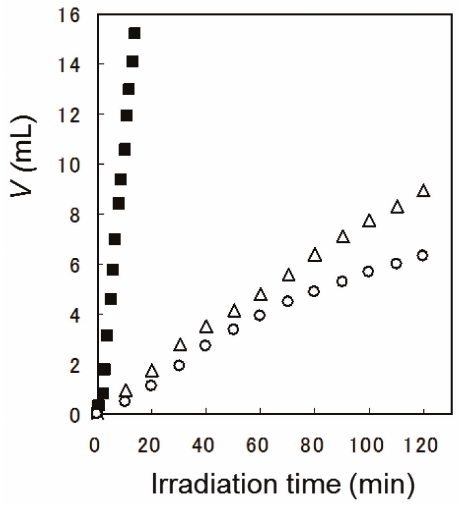
Figure 9. Time-conversion plots of the evolved gas volume ( V ) in the Pt/TiO reaction using 1-propylamine ( 1i , ■ ), propanal ( Δ ), and propanoic acid ( 2i , ○